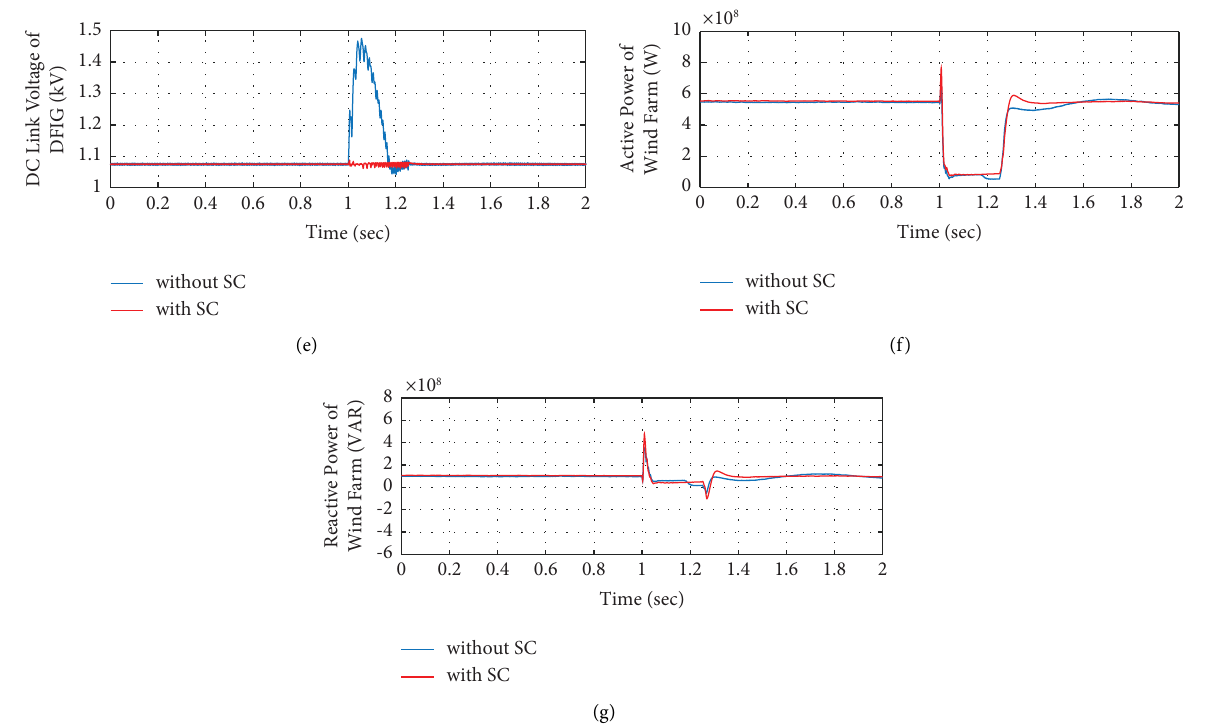
Figure 17: Performance during a double-line-to-ground fault. (a) Te AC voltage at B575, (b) the DC voltage of the APF capacitor, (c) the load active power, (d) the load reactive power, (e) the DC-link voltage of the back-to-back converter, (f) the total active power of the wind farm, and (g) the total reactive power of the wind